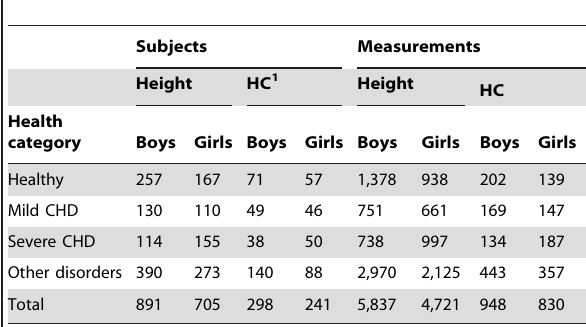
Table 2. Number of subjects and measurements for